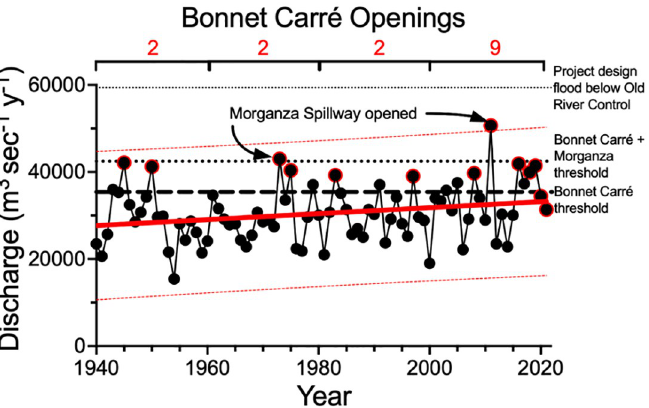
Fig 9. The maximum annual Mississippi River discharge at Vicksburg, MS, within the context of a linear regression of the discharge trend from 1940 to 2021. The thick red line is the predicted discharge, and the dashed red lines are the ± 99% confidence limits; the capacity of the US Corps of Engineers ‘Project Design Flood’ below the Old River Control Structure is the fine dotted line at the top of the figure. The openings of the Bonnet Carre ´ and Morganza spillways upstream of New Orleans, LA, (black circles with red borders) are indicated with the thresholds for opening each. The Bonnet Carre´ Spillway was opened twice in both 2019 and